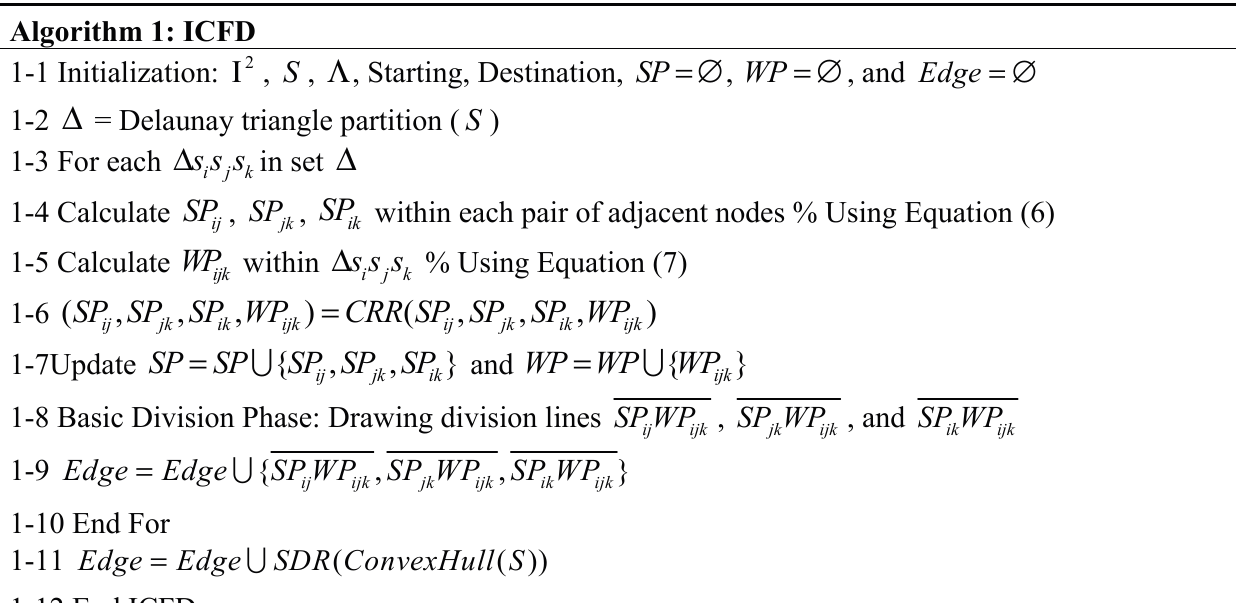
1-8 Basic Division Phase: Drawing division